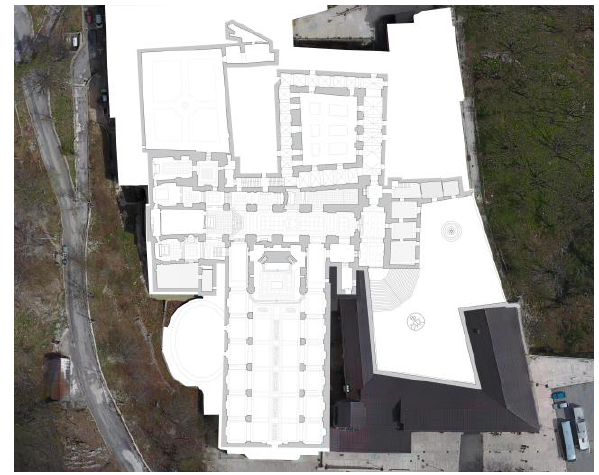
Figure 15. Combination of planimetric